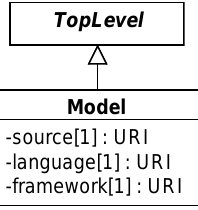
Figure 19: Diagram of the Model class and its associated